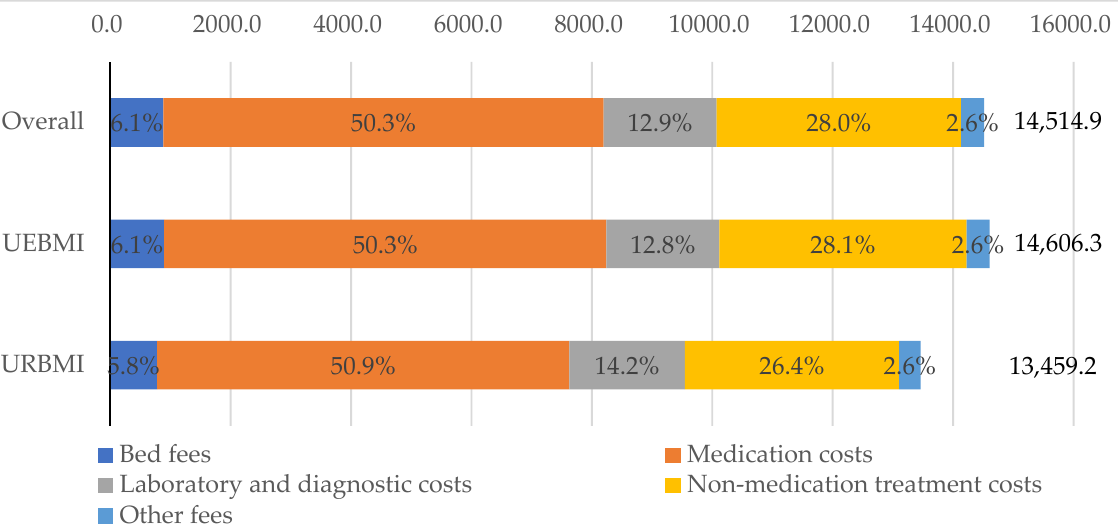
Figure 1. Composition of direct medical costs of Parkinson’s disease patients. Notes: All costs were